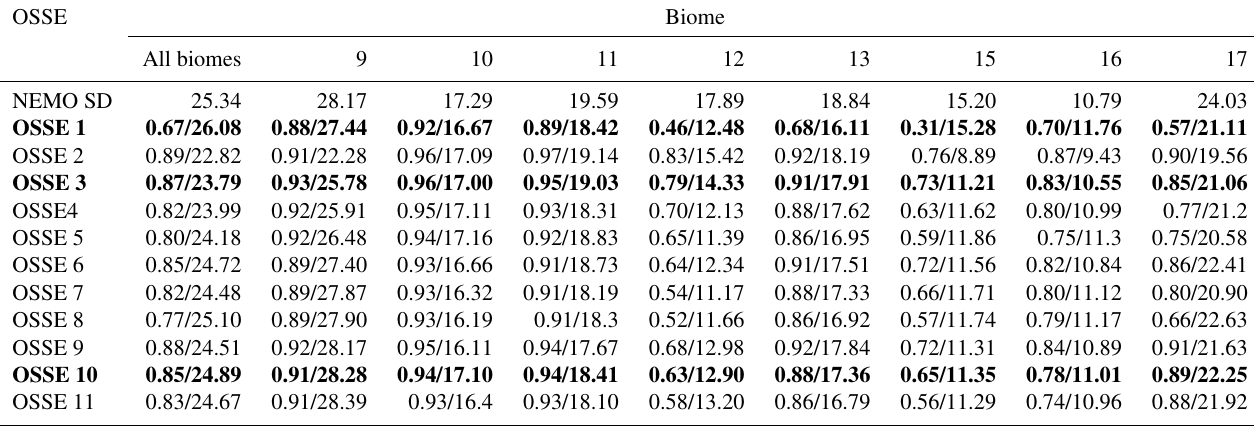
Table 3. Correlation coefficient and standard deviation (µatm) of 11 OSSEs from Table 2 estimated over eight Atlantic Ocean biomes and at basin scale; the results are presented in Fig. 3. OSSEs 1, 3 and 10 are in bold as we focus our detailed comparison on these three OSSEs. OSSE Biome